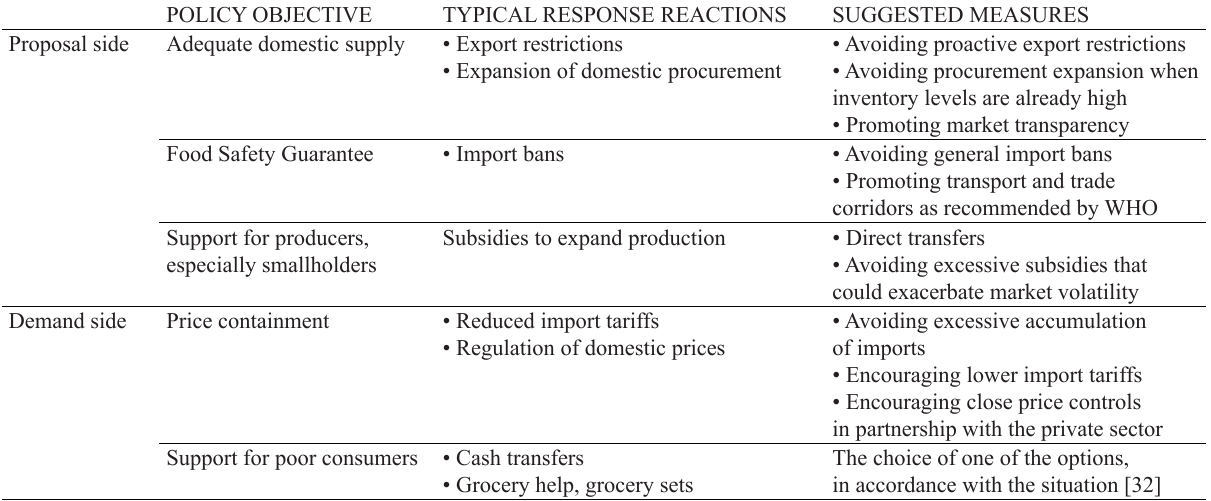
Table 1 Political goals and response during epidemic food crises POLICY OBJECTIVE TYPICAL RESPONSE